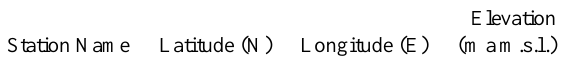
Table 1. Information about different meteorological stations in Satluj River basin in India.